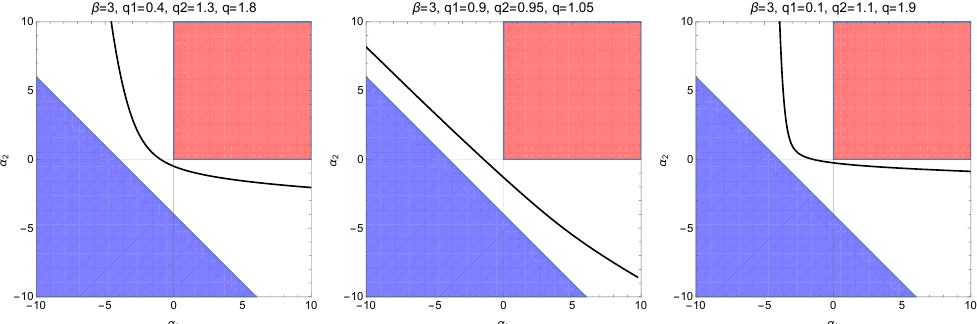
Figure 1. Parametric curves Γ ( β , q 1 , q 2 , q ) (black) for β = 3 and several values of the fractional orders q 1 , q 2 and q . The blue and red regions represent the fractional-order-independent instability and asymptotic stability regions, given by Lemma 1 and Lemma 2,